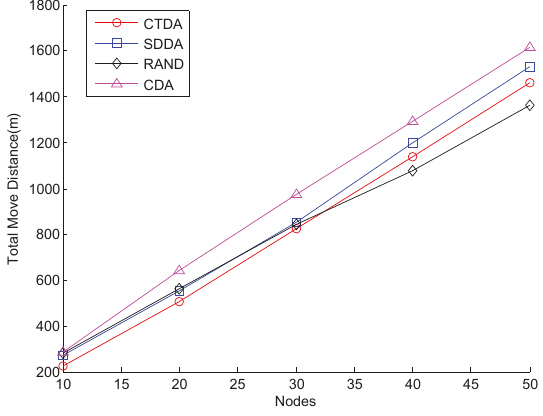
Figure 8. Comparison of total moved distance at varying numbers of nodes.